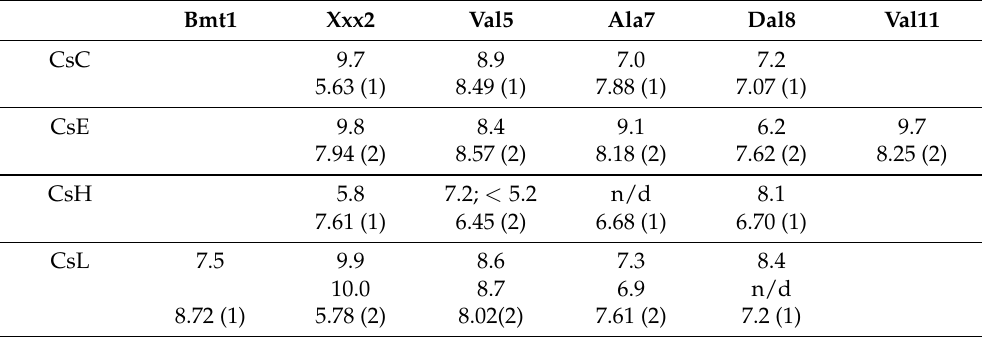
Table 2. 3 J (NH–H α ) couplings in cyclosporins (Hz), measured from NMR spectra and calculated from MD trajectories. Numbers (1) and (2) stand for the uni- and bimodal angle distributions in the simulation. Residue Xxx2 is Thr or Abu in different cyclosporins (see Table 1). The 1 H NMR spectrum of cyclosporin L shows two coexisting